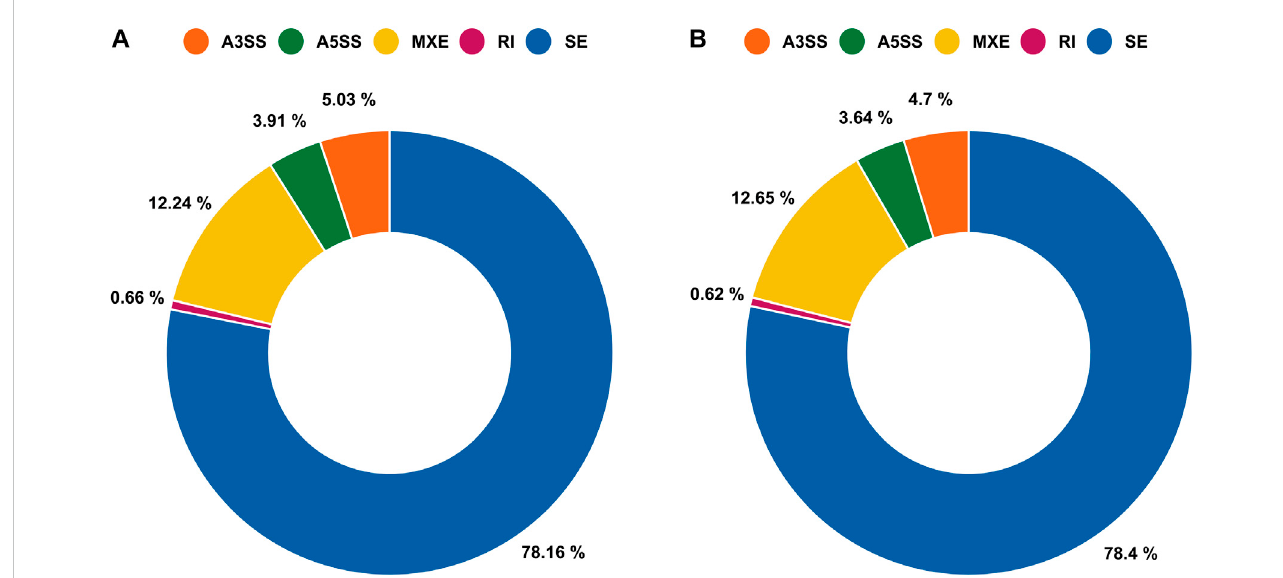
FIGURE 4 Alternativesplicingevents(ASEs)betweengillsandlungsofaestivatinglung fi sh. (A) CirclechartshowingthepercentdistributionofASEsingills. (B) Circle chart showing the percent distribution of ASEs in lungs.